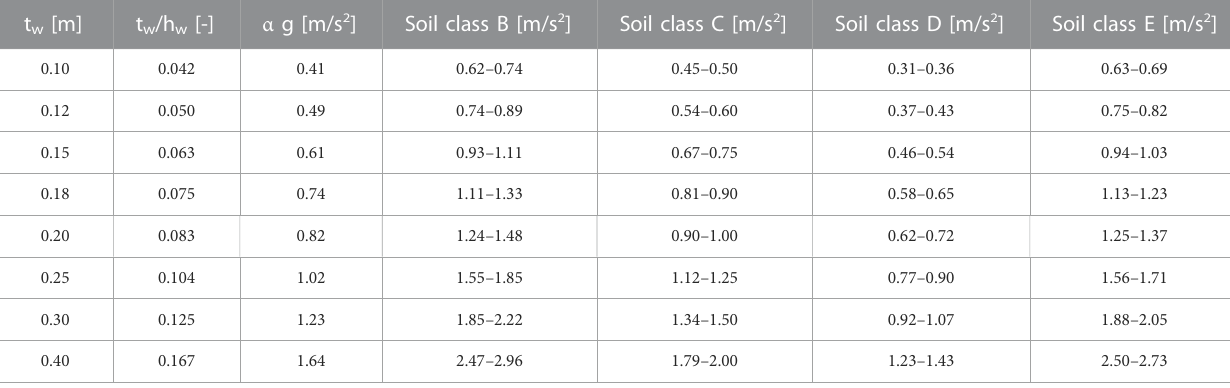
TABLE 3 Results of NLTHA for a wall height of 2.4 m and different soil classes with respect to the wall thickness (t w ). The fi gures provide considered ultimate ground accelerations (mean 12 TH > 0.4 · 2/3 · t w ) for damping ratios between 3% and 5%.